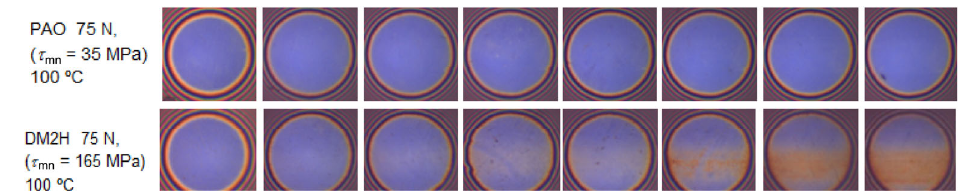
Fig. 16 Comparison of optical interference images for ZDDP solution in PAO and DM2H over a four-hour test at 75 N and 100 °C ( U = 3 m/s, SRR = 3%)